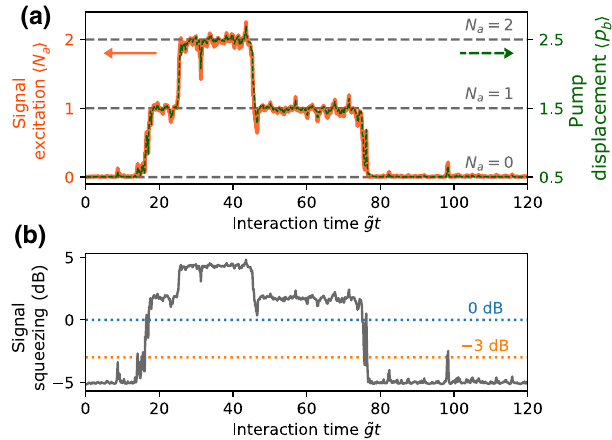
FIG. 4. A typical stochastic master equation quantum trajec- tory of the OPO dynamics unraveled by a continuous pump p -homodyne measurement. (a) Trajectories of (cid:9) ˆ N a (cid:5) (solid orange line, left axis) and (cid:9)ˆ p b (cid:5) (dashed green line, right axis) com- pared with the expected levels of the plateaus (cid:9)ˆ p b (cid:5) = Im (β N (dashed gray lines). (b) A trajectory of the signal x -quadrature squeezing compared with the quadrature noise levels for a vac- uum (0 dB, dotted blue line) and the squeezing limit for an OPO steady-state ( − 3 dB, dotted orange line). We use Eq. (7) with system parameters (cid:9)/ g = 100, ˜ g / g = 1.5, κ a / g = 0.03, and κ b / g =